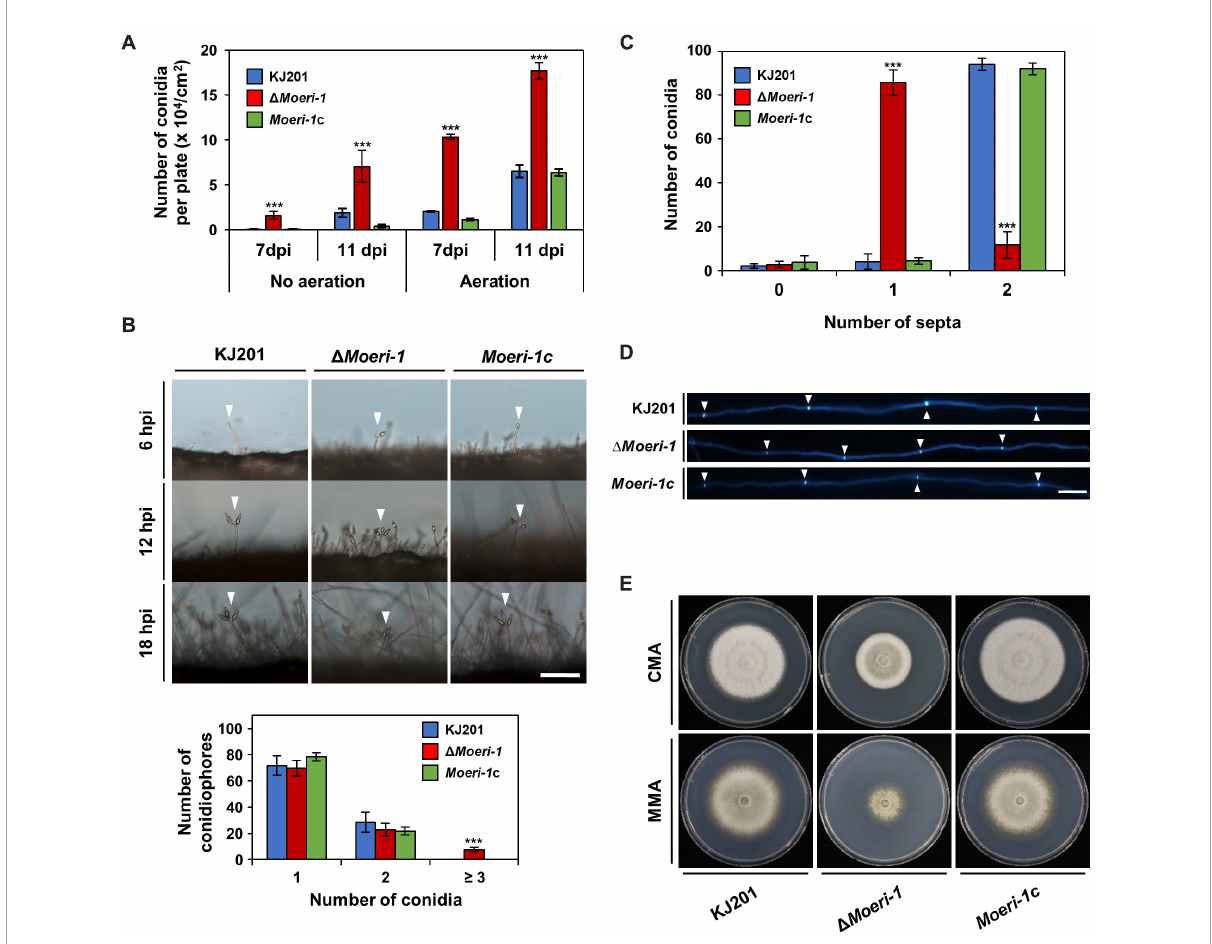
FIGURE5 Phenotypes of (cid:49) Moeri-1 . (A) Conidiation assay of WT, (cid:49) Moeri-1 , and the MoERI-1 complemented strain, Moeri-1 c, with or without aeration. Conidia of each strain were collected at 7 and 11 days post-inoculation (dpi). Each strain was counted in triplicate. (B) Conidiophores were observed under light microscopy at 6, 12, and 18 h post-induction (hpi). White arrowheads indicate the conidiophores with the conidia. One hundred conidiophores of each sample were counted at 12 hpi in triplicate. Scale bar, 40 µ m. (C) The number of conidia according to septum number was counted. One hundred conidia of each sample were counted in triplicate. Error bars indicate the standard deviations of mean values. *** p < 0.001, Student’s t -test between the mean values of the WT and the mutant strains. (D) Calcofluor white staining of mycelial septa. Scale bar, 40 µ m. (E) Mycelial growth on CMA and MMA at 25 ◦ C 9 days post